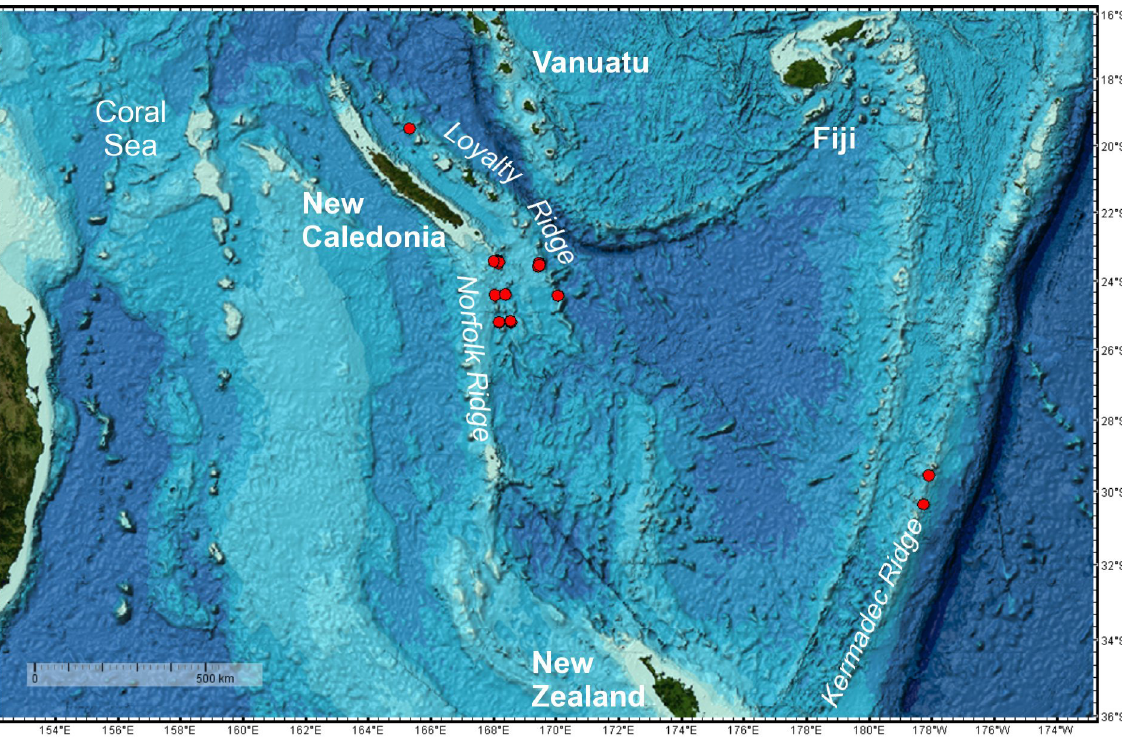
Fig. 14. Distribution map for Profundiconus puillandrei sp. nov. Red circles indicate the points where the species has been